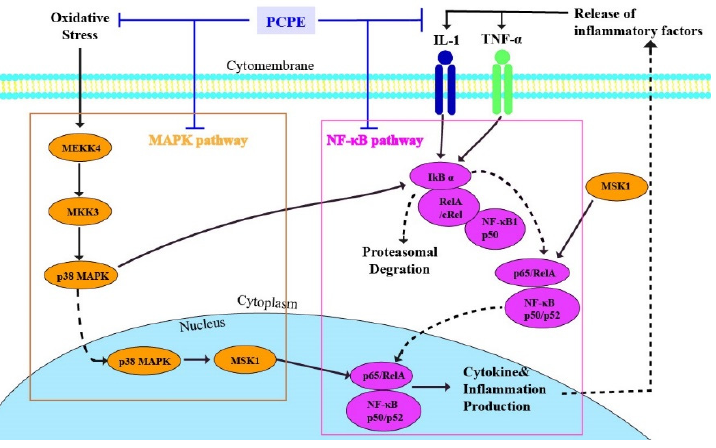
Figure 7. PCPE interactions with MAPK/NF ‐κ B signaling pathway during ALI in dogs.